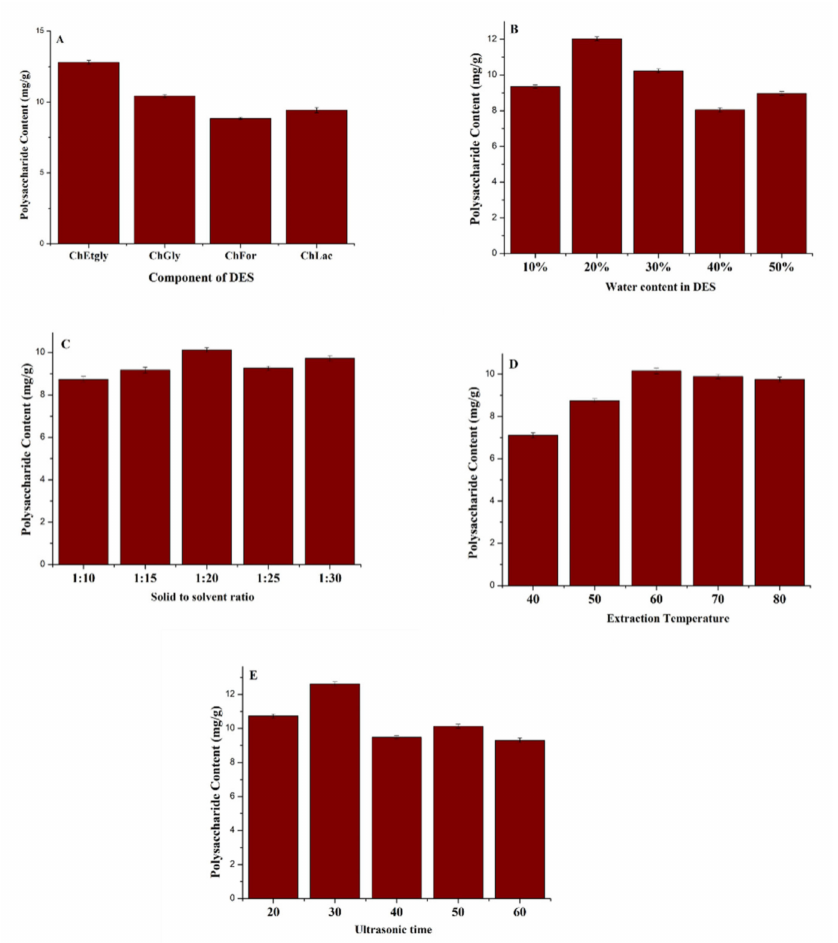
Figure 2. Optimized extraction process for DESs extraction (polysaccharide content (mg · g − 1 ) at different DESs ( A ), water contents in DES ( B ), solid to solvent ratios ( C ), extraction temperatures ( D ), and extraction times ( E